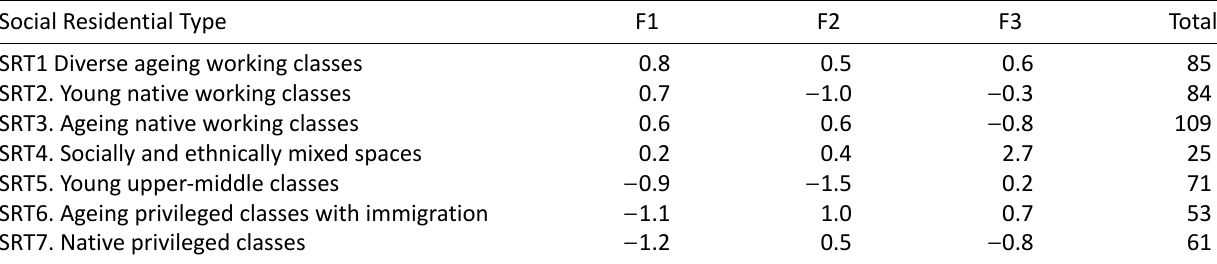
Table 2. Centre of each SRT in each social residential inequality factor.